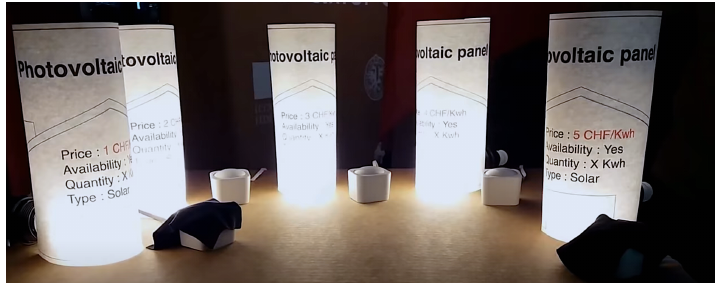
Figure 15. Service composition for energy management in a distributed system.